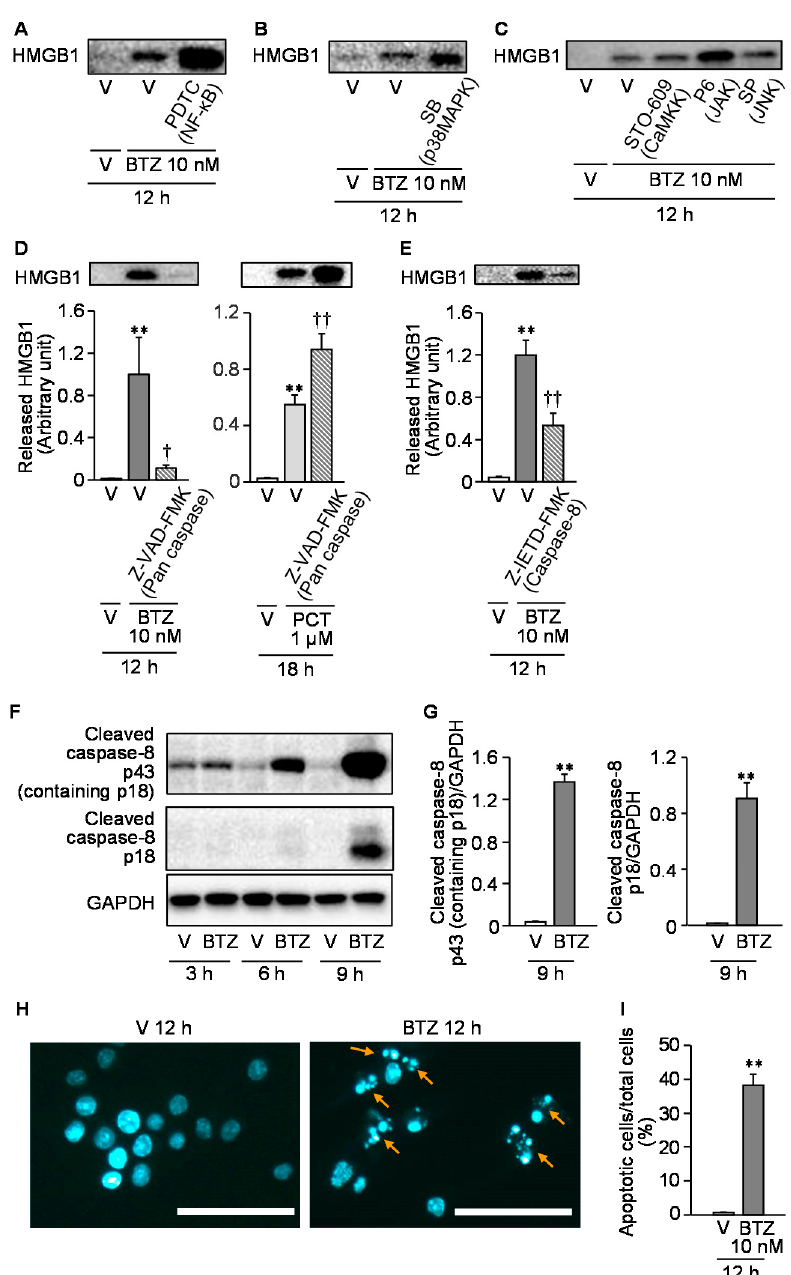
Figure 7. Analysis of cell signals involved in the bortezomib-induced HMGB1 release from RAW264.7 macrophages. ( A - C ) Lack of effects of pyrrolidine dithiocarbamate ( A ), SB203580 ( B ), STO-609, pyridone 6, and SP600125 ( C ), inhibitors of NF- κ B, p38MAPK, CaMKK, JAK, and JNK, respectively, on the HMGB1 release from RAW264.7 cells stimulated with bortezomib. Pyrrolidine dithiocarbamate at 100 µM ( A ), SB203580 at 1 µM ( B ), STO-609 at 10 µg/mL, pyridone 6 at 30 nM, or SP600125 at 1 µM ( C ) was added 1 h before stimulation with bortezomib at 10 nM for 12 h, and the extracellular HMGB1 was detected by Western blotting. ( D , E ) Effects of Z-VAD-FMK, a pan-caspase inhibitor, and Z-IETD-FMK, a caspase 8-specific inhibitor, on the HMGB1 release from RAW264.7 cells stimulated with bortezomib. Z-VAD-FMK at 20 µM ( D ) or Z-IETD-FMK at 20 µM ( E ) was added 1 h before stimulation with bortezomib at 10 nM for 12 h ( D , E ) or paclitaxel at 1 µM for 18 h ( D ), and the extracellular HMGB1 was detected and quantified by Western blotting. Typical photographs are shown on the top above the columns of quantified data. Parentheses indicate molecular targets of each inhibitor ( A – E ). ( F , G ) Increase in protein levels of cleaved products of caspase-8, p43 (containing p18) and p18 following stimulation with bortezomib at 10 nM for 3–9 h ( F ) or for 9 h ( G ). The cleaved products were detected ( F ) and quantified ( G ) by Western blot analysis. ( H , I ) Detection of apoptotic cells after stimulation of bortezomib at 10 nM for 12 h. Nuclear fragmentation or condensation accompanying apoptosis (arrows) was detected by Hoechst 33342 staining ( H ), and the proportion (%) of apoptotic cells in a visual field was calculated ( I ). Scale bars indicate 50 μ m. Data show the mean with S.E.M for 7 ( D left),